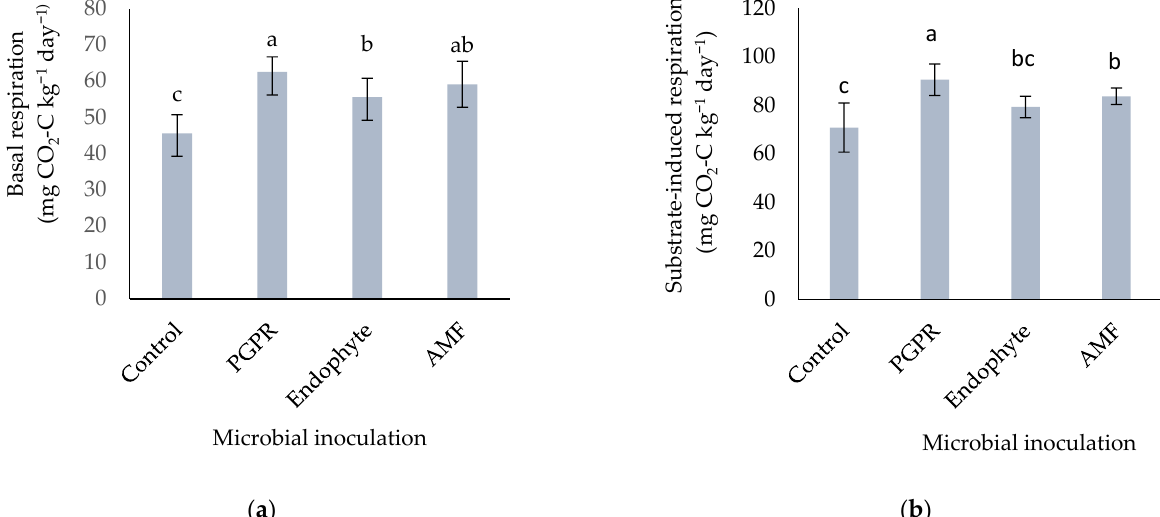
Figure 3. The effect of microbial inoculation on ( a ) basal respiration and ( b ) substrate-induced respiration. Bars show means ± standard error of the mean. Means with a different letters indicate significantly different values at p < 0.05 based on Duncan’s multiple range